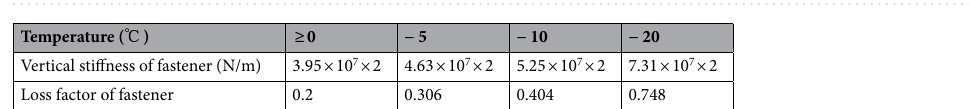
Figure 14. Experiment results of ( a ) vertical stiffness and ( b ) damping of WJ-8 fastener at different temperatures.